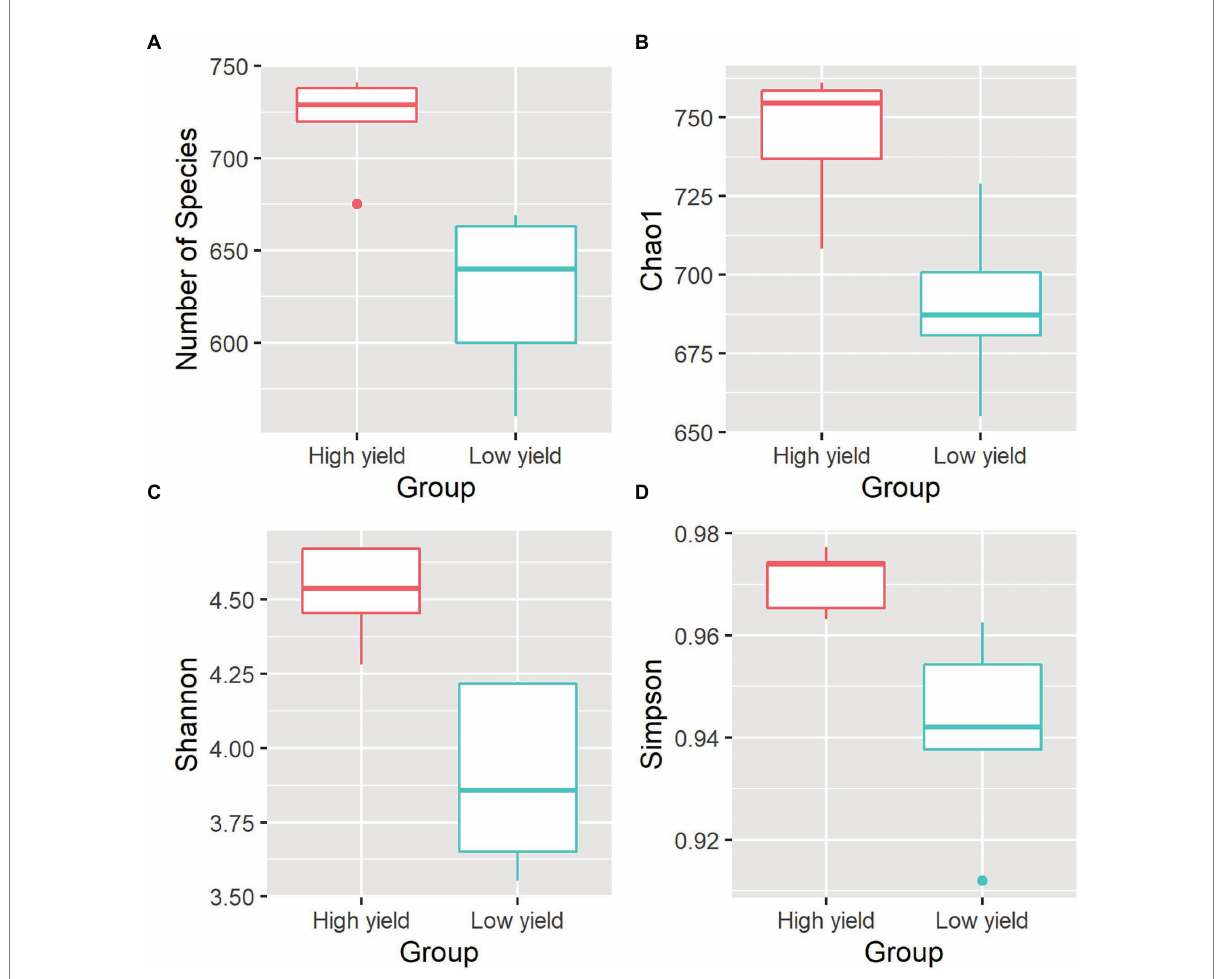
FIGURE 2 Alpha diversity indices of the bacterial community in spent mushroom substrate samples in group A and group B. All indices are plotted for samples in group A (red) and group B (cyan). The line inside the box represents the median. Statistical analysis shows significant differences of samples in group A and group B for all indices (pObserved = 0.006272, pChao 1 = 0.008897, pShannon = 0.007275, pSimpson = 0.025268). The panels shown are (A) the numbers of species identified, (B) Chao1 diversity index, (C) Shannon diversity index, and (D) Simpson diversity